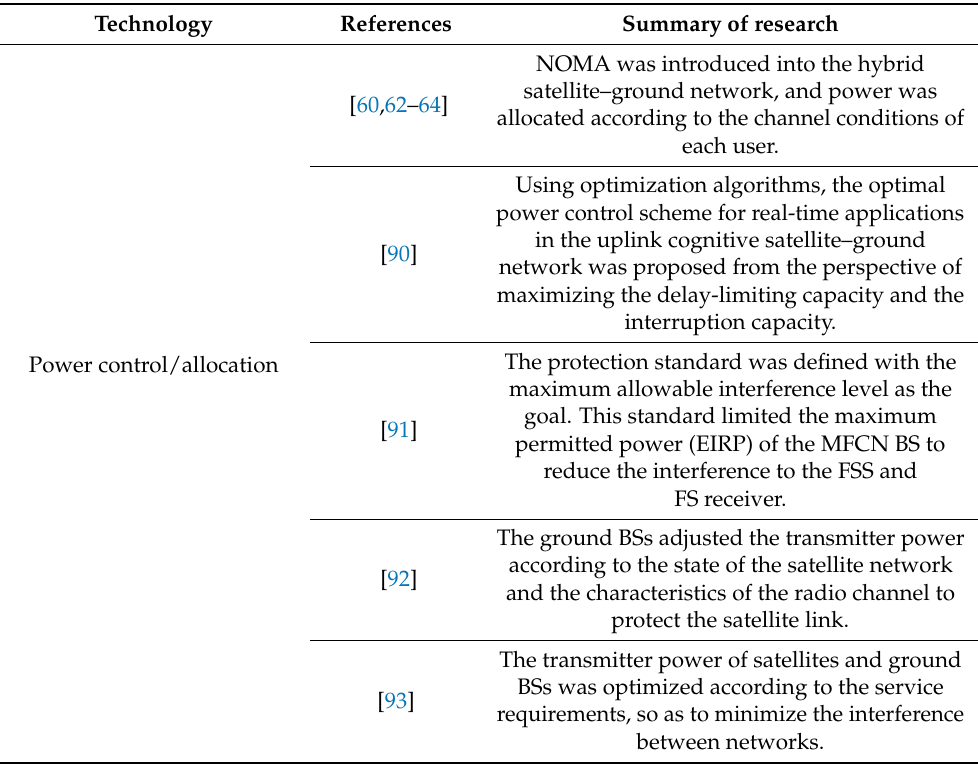
Table 8. Reference related to power